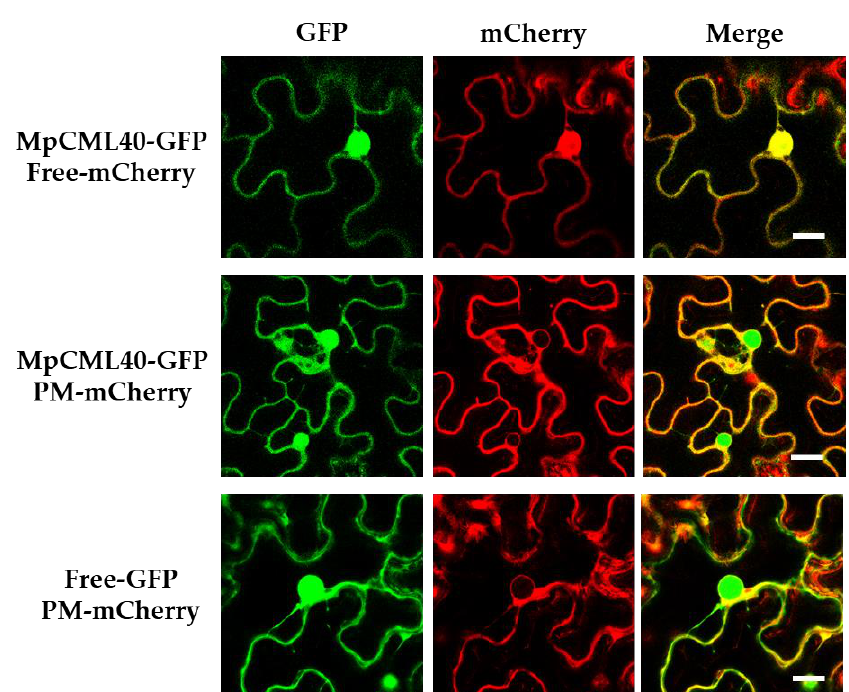
Figure 3. Subcellular localization of MpCML40-GFP. Subcellular localization of MpCML40-GFP was assayed with plasma membrane (PM-mcherry) marker or free mcherry in tobacco leaf epidermal cells. The fluorescence signals were detected 48 h after infiltration. Bar = 20 μM. The experiments were repeated two times with similar results. Table 2. The list of primer